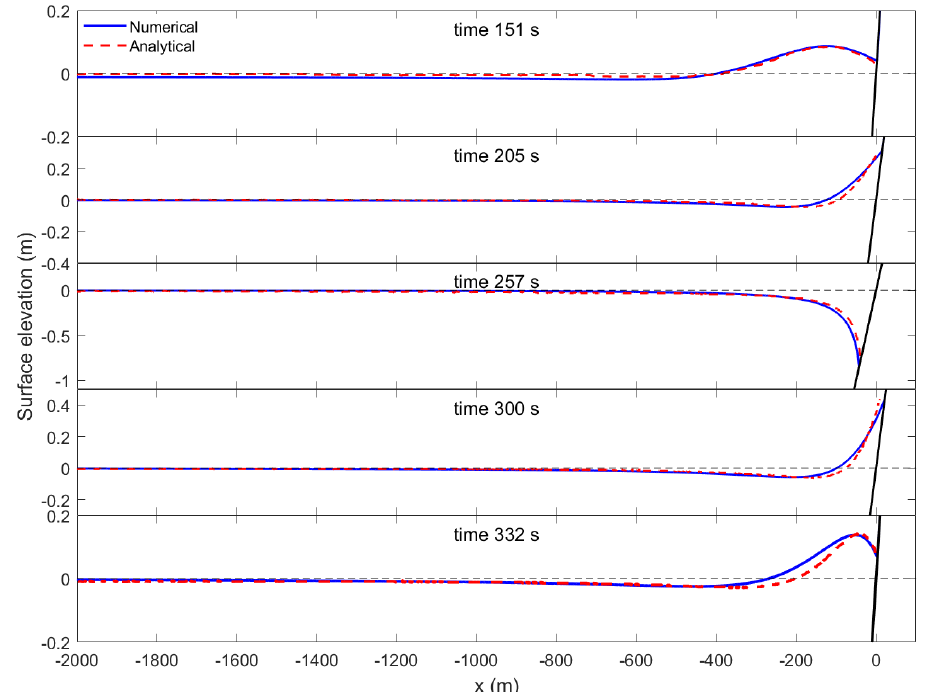
Figure 5. Snapshots of free surface motion in a U-shaped bay of B 2/3 , our numerical result is compared with the analytical surface